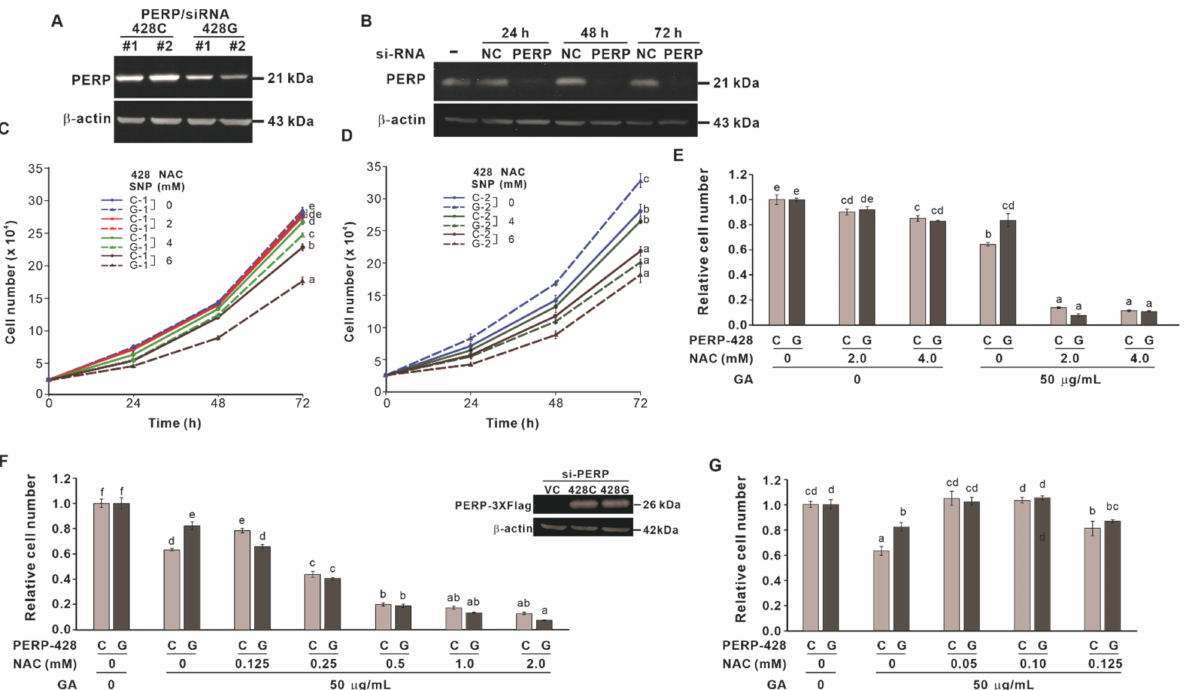
Figure 4. The effect of NAC and GA on the proliferation of CL1-0 cells expressing different PERP - 428 variants. ( A ) Expression of PERP protein in CL1-0/ PERP-428C and CL1-0/ PERP-428G stable clones. ( B ) Knockdown efficiency of si- PERP in A549 cells. si-NC: si-negative control. ( C , D ) NAC at 4 or 6 mM inhibited the proliferation of CL1-0/ PERP-428G -expressing cells (dashed lines) much more significantly than that of CL1-0/ PERP-428C -expressing cells (solid lines). One-way ANOVA and